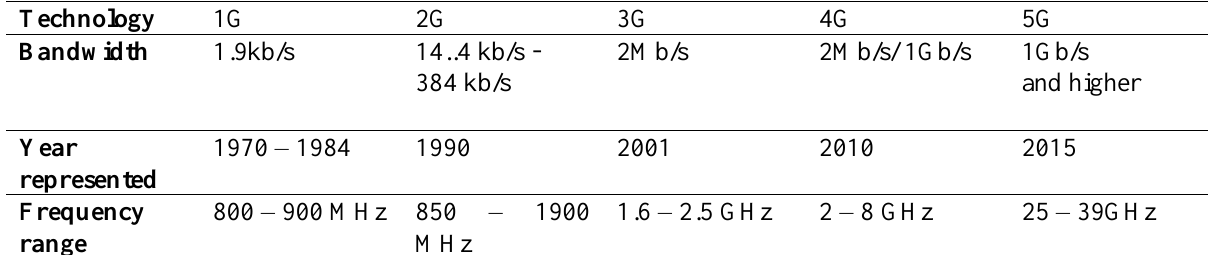
Table 1. Description of wireless network generations through